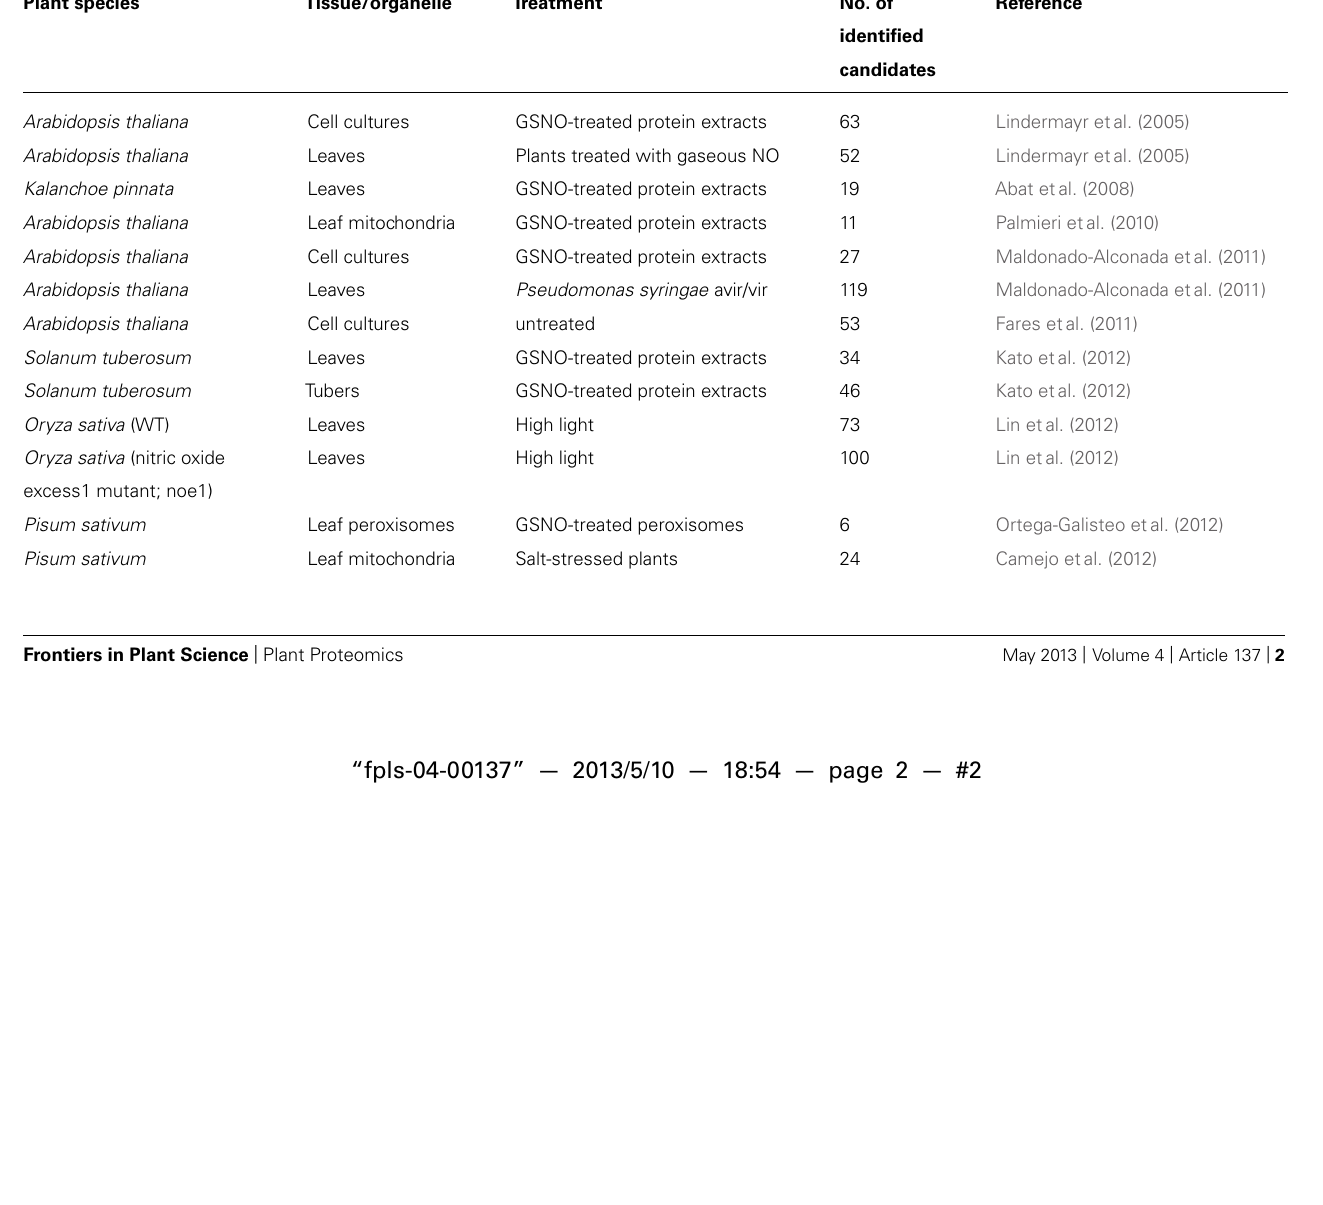
Table 1 | Summary of proteomics approaches to identify candidate proteins for S -nitrosylation in plants. Plant species Tissue/organelle Treatment No. of Reference Arabidopsis thaliana Cell cultures GSNO-treated protein extracts Arabidopsis thaliana Leaves Plants treated with gaseous NO Kalanchoe pinnata Leaves GSNO-treated protein extracts Arabidopsis thaliana Leaf mitochondria GSNO-treated protein extracts Arabidopsis thaliana Cell cultures GSNO-treated protein extracts Maldonado-Alconada etal. (2011) Arabidopsis thaliana Leaves Pseudomonas syringae avir/vir Arabidopsis thaliana Cell cultures untreated Solanum tuberosum